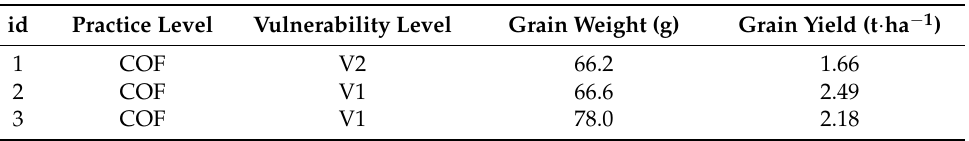
Table 8. Grain yield in sampling points. Grain weight was measured from about 50 plants from each point on a variable surface (not